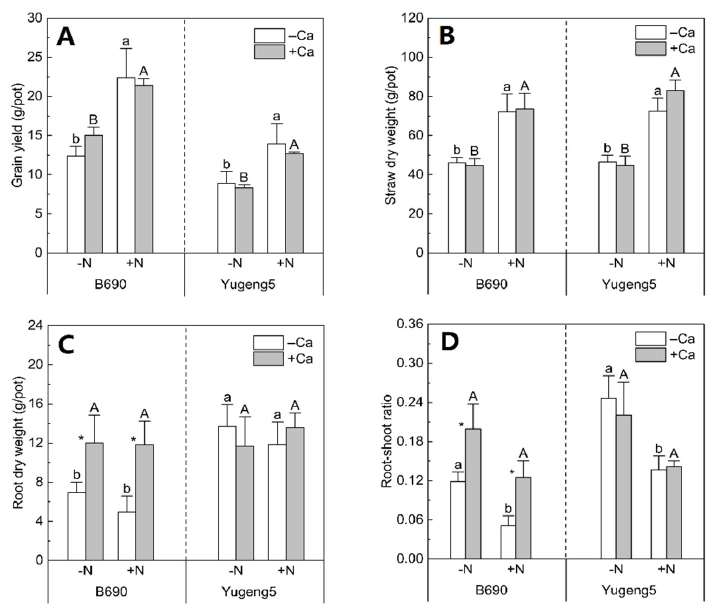
Figure 2. E ff ects of nitrogen (N) and lime on biomass of two rice cultivars, ‘B690’ and ‘Yugeng5’. ( A ), Grain yield; ( B ), straw dry weight; ( C ), root dry weight; ( D ), root–shoot ratio. Root–shoot ratio; ratio of root dry weight to aboveground dry weight. Two rice cultivars were grown in pots in a greenhouse without ( − N) or with (+N) N fertilizer, in the absence ( − Ca) or presence (+Ca) of lime, till maturity. Different lowercase and capital letters above bars indicate significant differences between − N and +N treatments under − Ca and +Ca conditions for the same rice cultivar, respectively ( p < 0.05, independent-sample t test). Asterisks indicate significant differences between − Ca and +Ca treatments for the same rice cultivar ( p < 0.05, independent-samples t test). Plants 2020 , 9 , x FOR PEER REVIEW